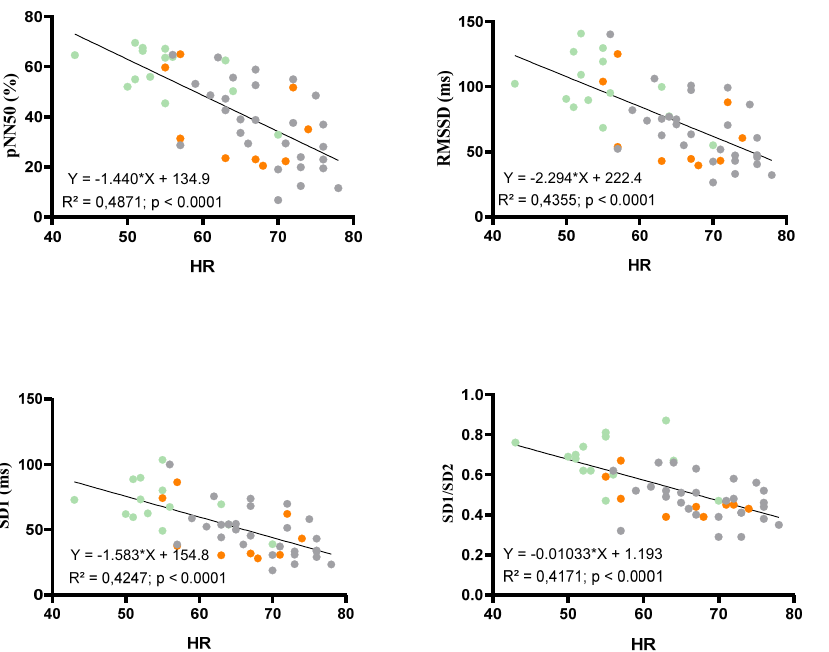
Figure 4. Relations between HR and HRV parameters (PNN50, RMSSD, SD1, SD1/SD2) with a single linear regression. Orange circles : AN patients with WR, green circles : AN patients without WR and grey circles: Controls. Table 2. Left ventricular morphology and function in AN patients without and with WR and